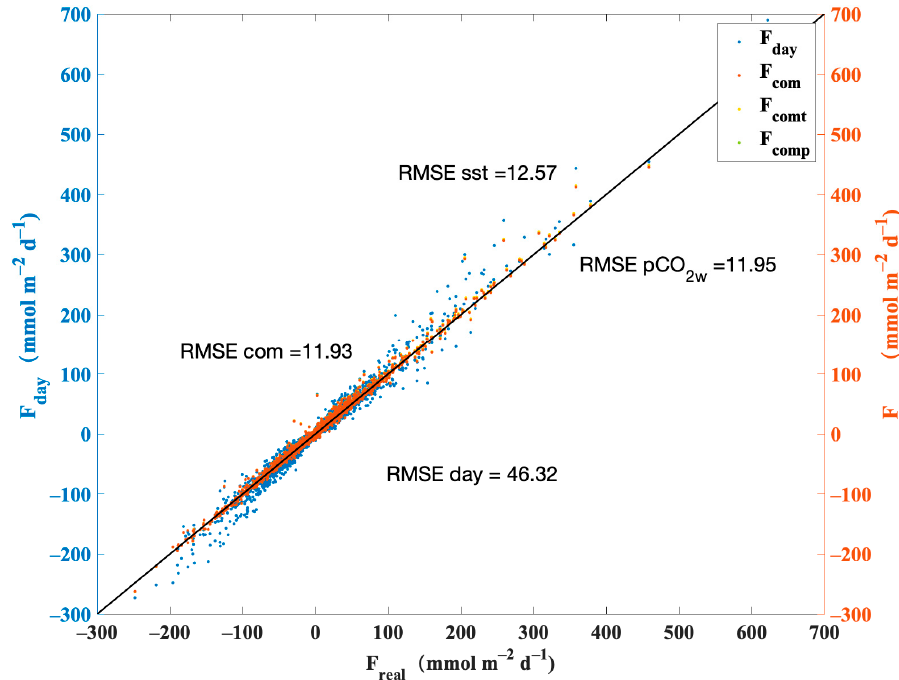
Figure 11. Results of using 25% of the data from 2010 to 2020 verify the calculated nocturnal effect.